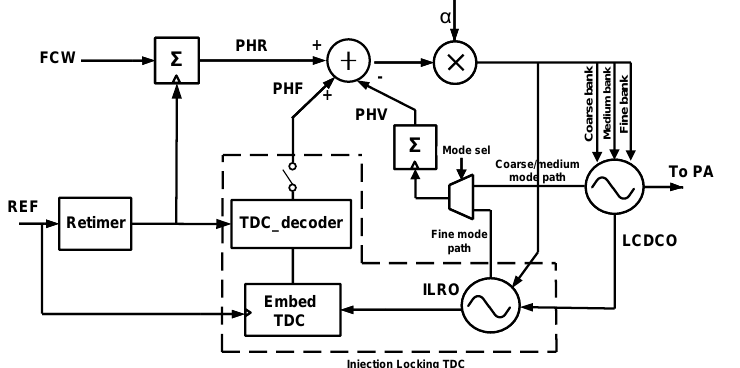
Figure 5. Block diagram of the proposed ADPLL.